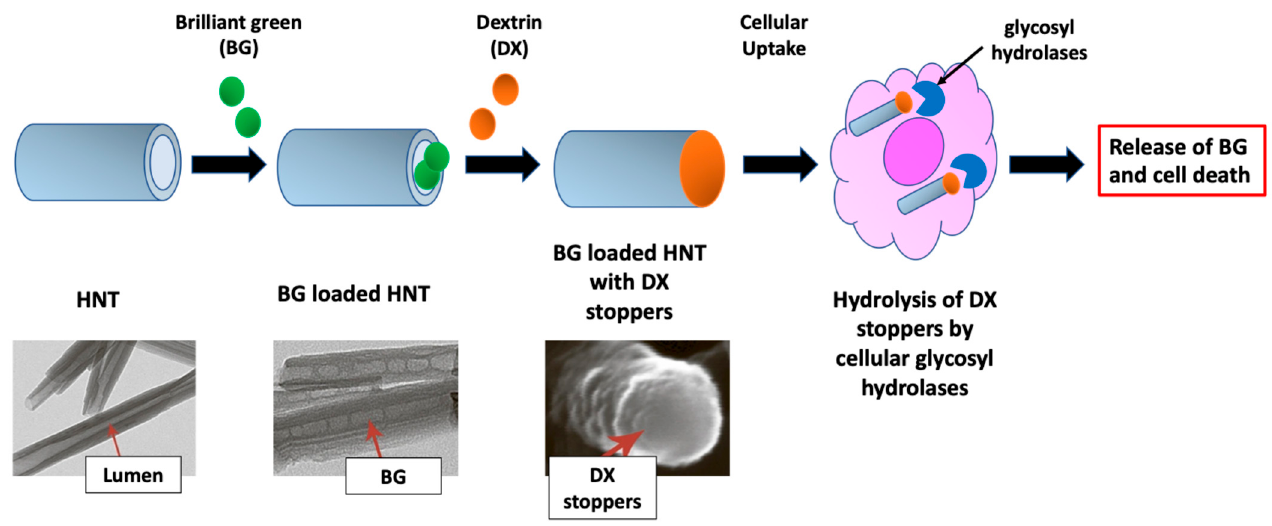
Figure 5. BG-loaded HNT and the application of DX tube end caps for a release of BG activated by intracellular glycolysis hydrolases. Adapted from ref. [83].